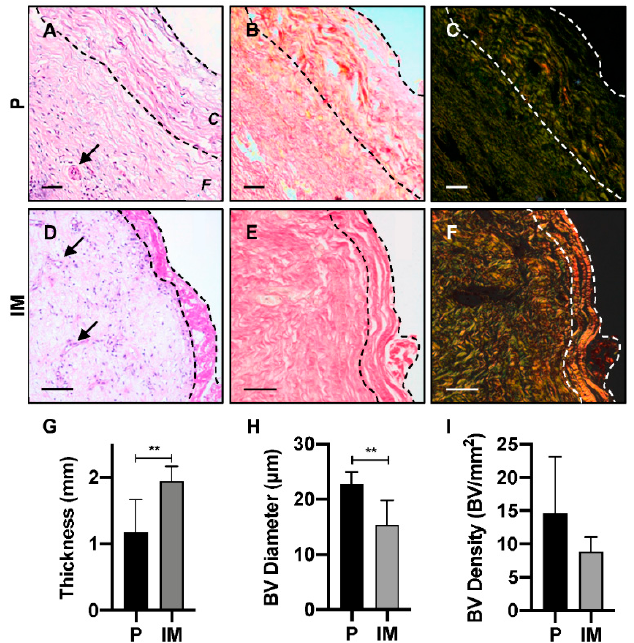
Figure 1. Histological analysis of periosteum (P) and IM samples. ( A – F ) Analysis of tissue architecture and cellular location, using haematoxylin & eosin (left column) and Picro Sirius Red staining under light microscopy (middle column) and polarised microscopy (right column). ( G ) Tissue thickness, ( H ) blood vessel diameter and ( I ) blood vessel density were quantified. Scale bar represents 50 µ m. Dotted lines—outline cambium layer, arrow—blood vessel (BV), C —cambium layer, F —fibrous layer. Unpaired t-test, ** p < 0.004.